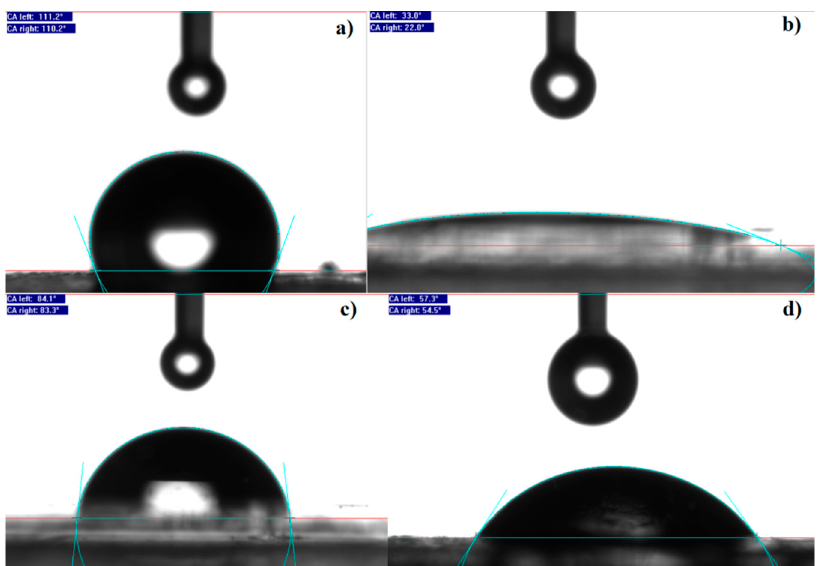
Figure 16. Wettability study of polymers ( a ) PLA, ( b ) PEG, ( c ) PLA-PEG, and ( d ) PLA-PEG-heparin.